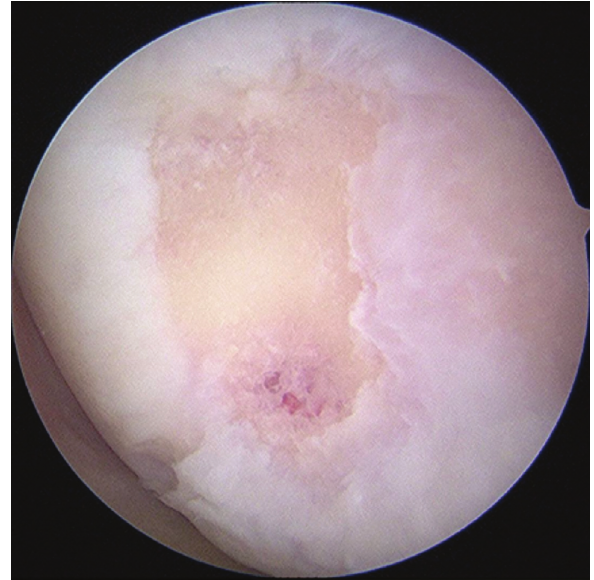
Fig. 1: Arthroscopy image, viewing from the anterolateral portal showing medial femoral condyle full thickness cartilage defect measuring 1.5cm by 1.5cm in size.